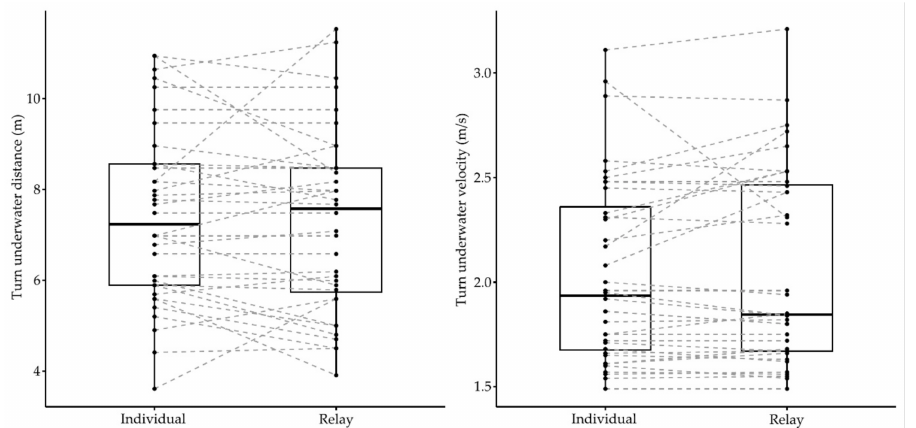
Figure 4. Individual and group variation in the underwater turn phase between individual and relay events of the LEN European Junior Swimming Championships.